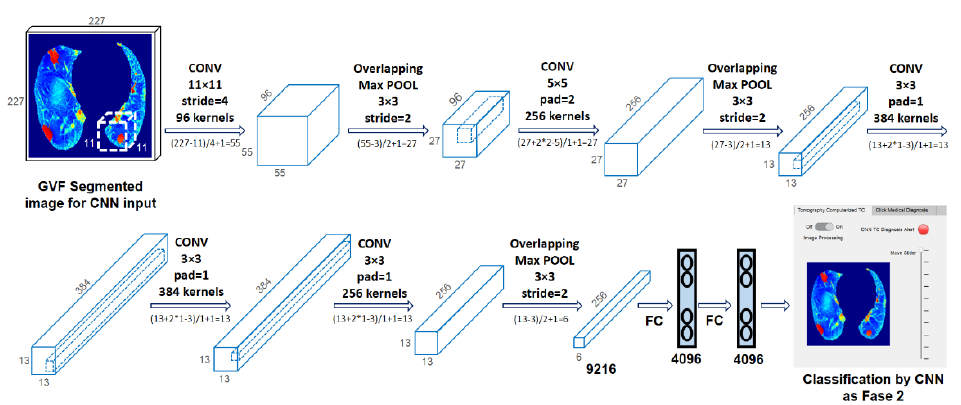
Figure 6. Convolutional neural network [41].